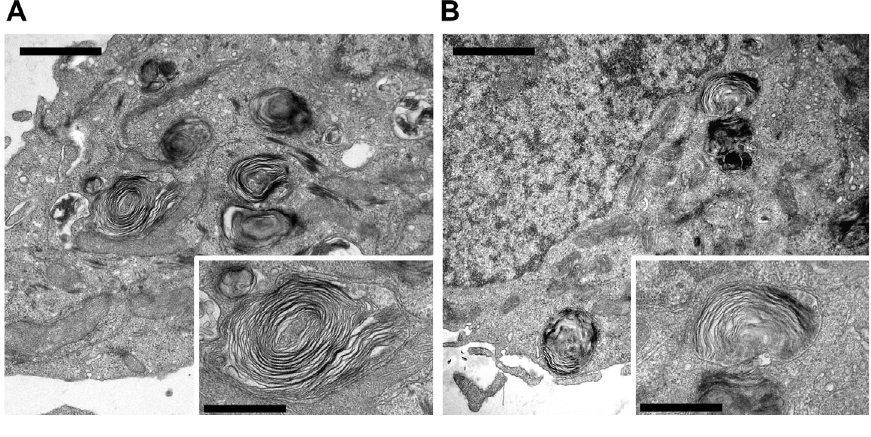
Figure 3. Transmission electron microscopy. Electron microscopy of A549 cells expressing ABCA3-WT (A) or ABCA3-R288K (B). Several lamellar bodies are visible in the overviews. These exhibit concentric lamellae, as distinguishable in the higher magnifications (insets). Scale bars are 1 μ m for overviews and 0.5 μ m for insets.